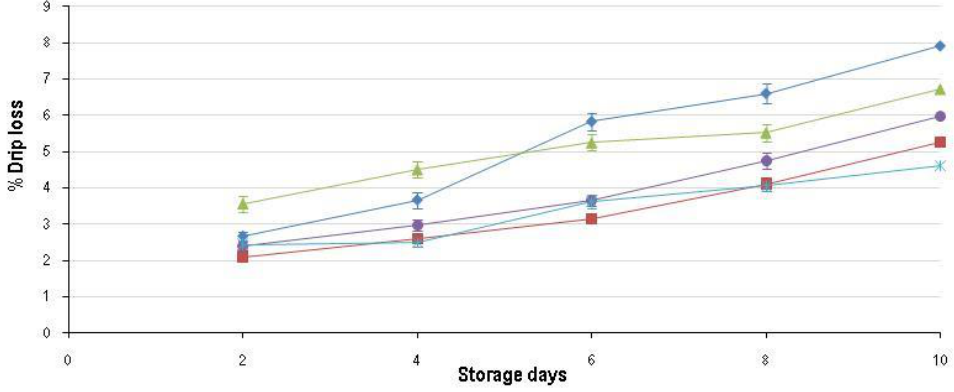
Figure 2. Average cooking loss (±std. error) for the five characteristic freezing rates: FR_1h ( ); FR_2h ( ); FR_4h ( ); FR_8h ( ) and FR_24h ( ) over the 10-day shelf-life trial at ±4 °C.